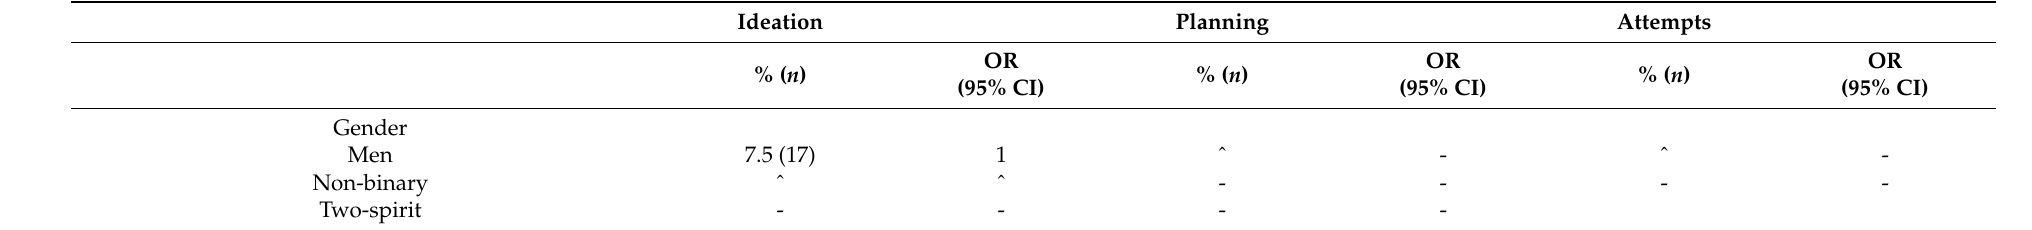
Table 3. Associations between Sociodemographic Covariates and Past-Year Suicidal ideation, planning, and